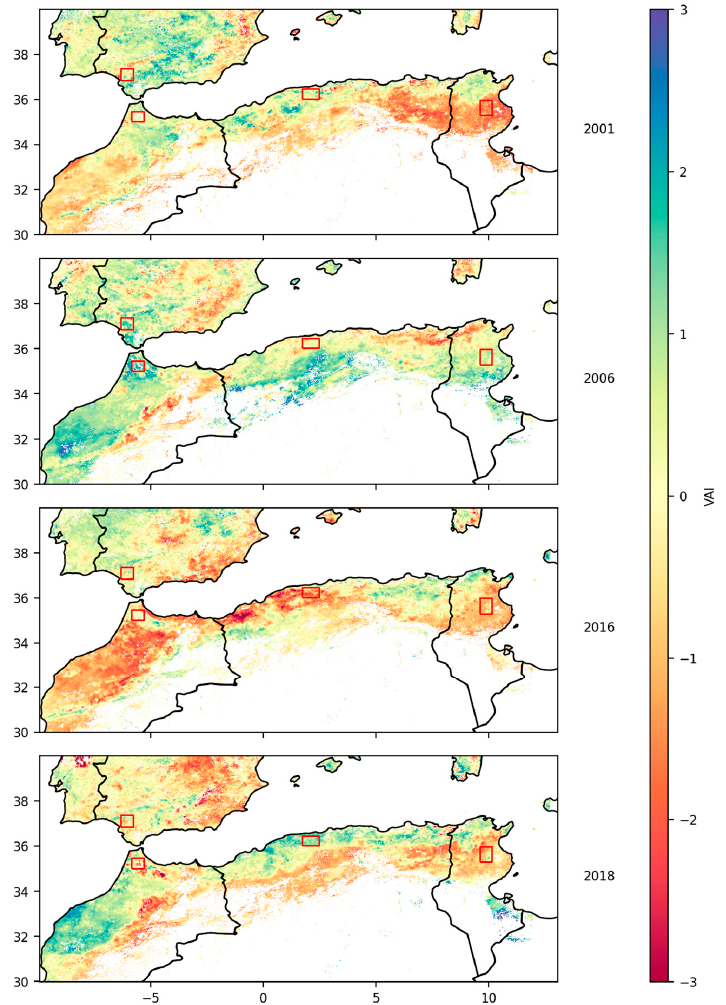
Figure 6. Maps of the VAI combining calculations for crops and natural areas over the studied region, in March 2001, March 2006, March 2016, and March 2018.